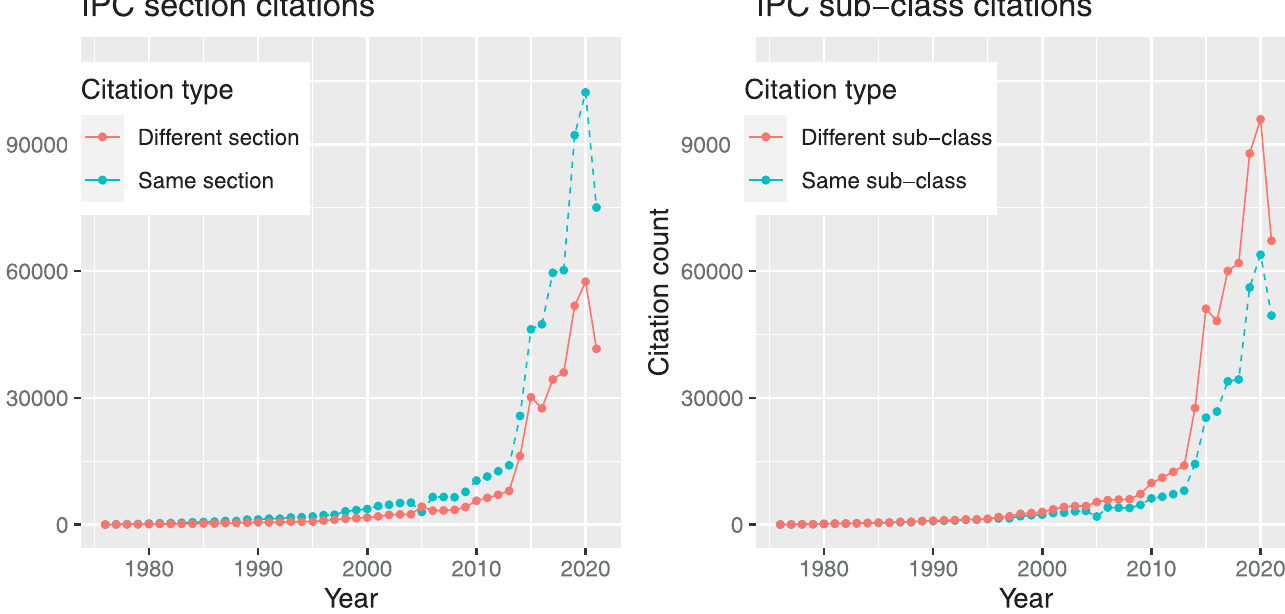
PLOS ONE | https://doi.org/10.1371/journal.pone.0283247 March 20,